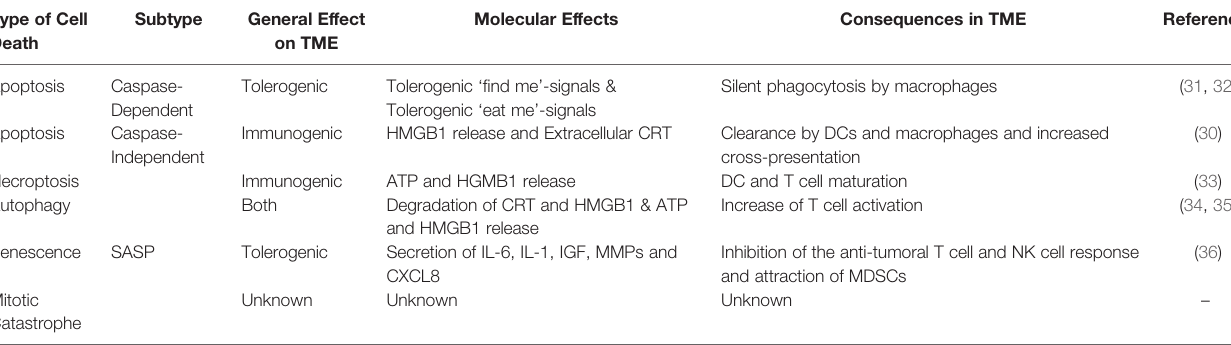
TABLE 1 | Overview of effects of tumor cell death to the tumor